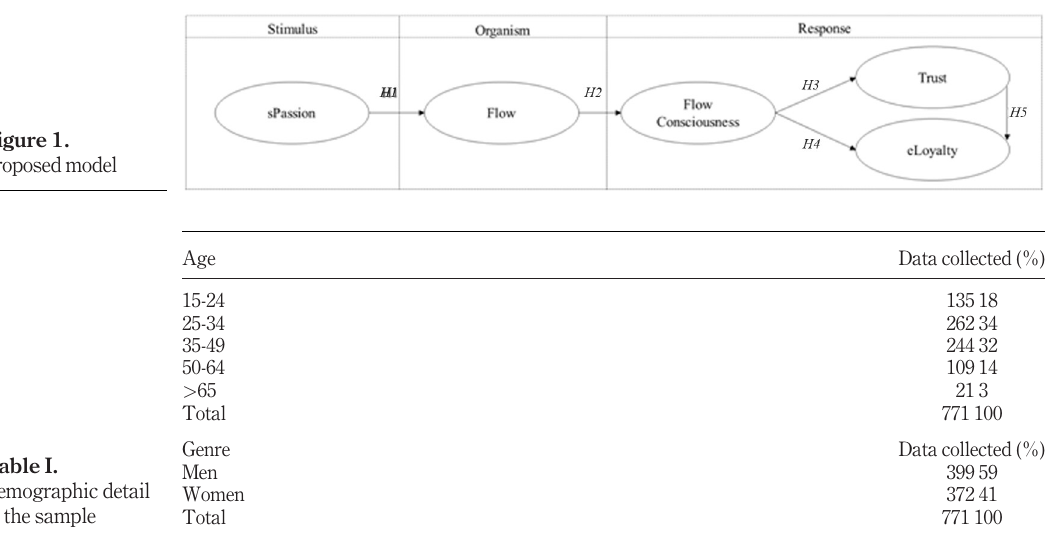
Demographic detail of the